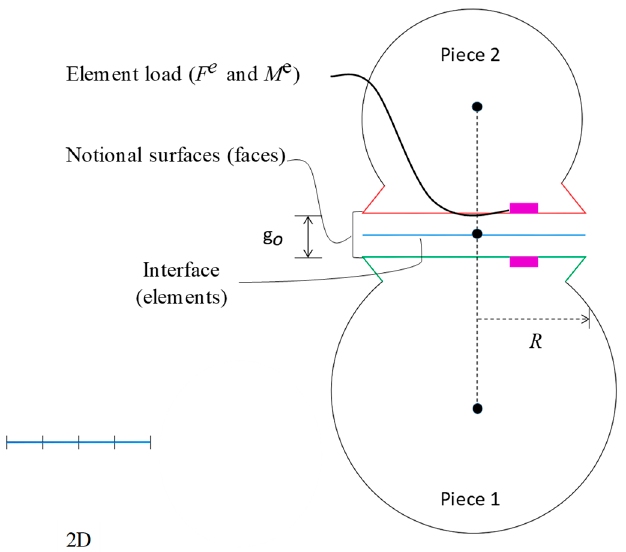
Figure 1. A typical schematic diagram of the FJM [38]. Note R represents the half-length of the FJM interface.